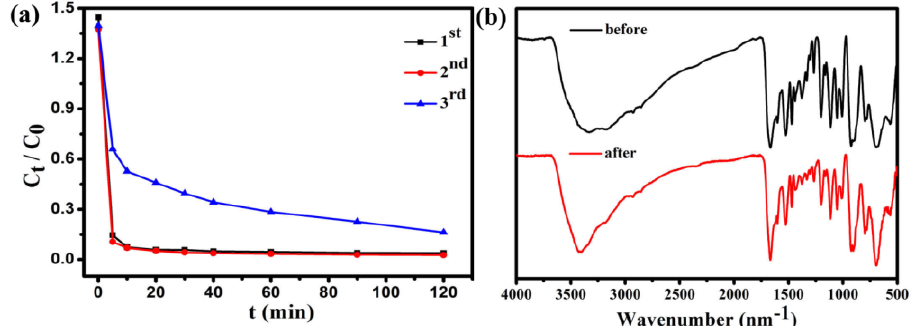
Figure 11. ( a ) Reuse performance of the Fe 3 O 4 @1 adsorption experiments; ( b ) IR spectra of the fresh and recovered Fe 3 O 4 @1 .